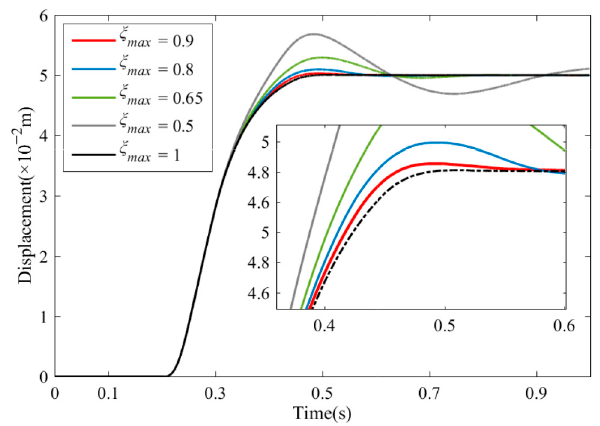
ξ . Figure 5. System response with different ξ max max